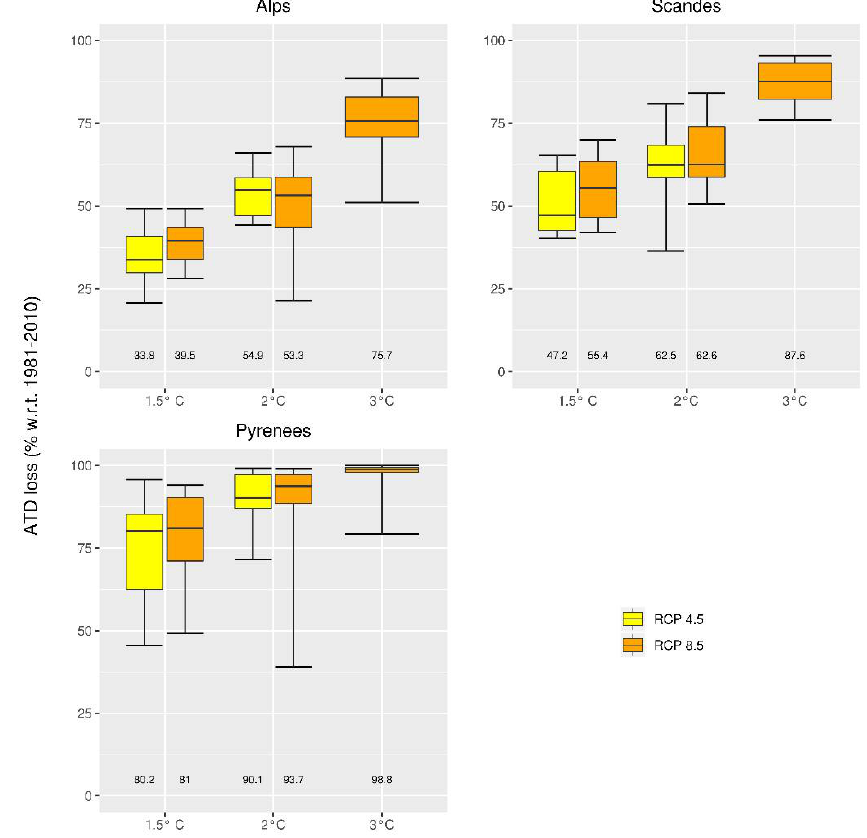
Figure 3. Projected relative area loss of the alpine tundra domain (ATD) under scenario RCP4.5 and RCP8.5 in three waring levels (1.5 °C, 2 °C and 3°C) in relation to the reference period (1981–2010) in the Alps, Scandes and Pyrenees. Box-and-whisker plots show the minimum, maximum, median (number), lower quartile (25%) and upper quartile (75%) of the 11 RCM simulations. The projected contraction of ATD vary considerably depending on the region